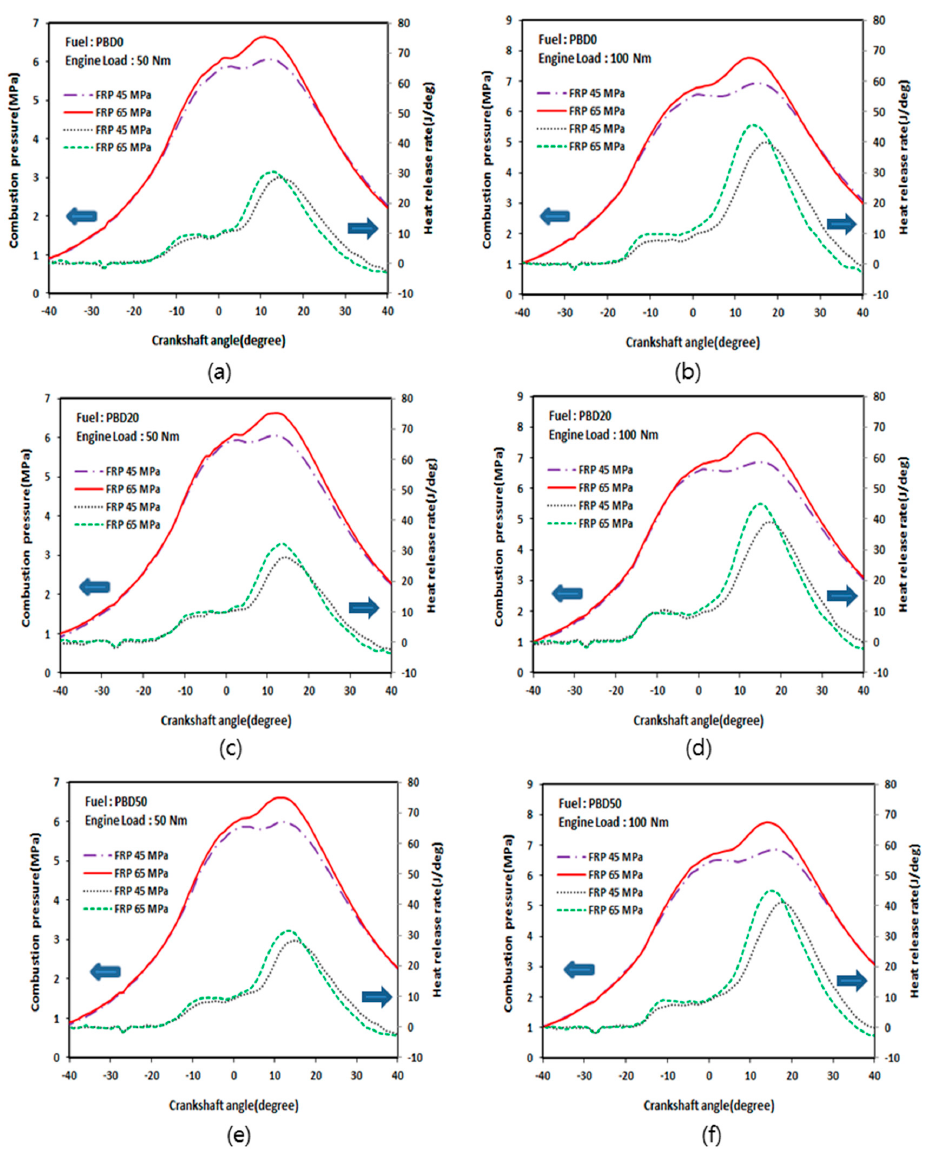
Figure 3. Combustion pressure and heat release rate in the combustion chamber for ( a ) PBD0 for an engine load of 50 Nm, ( b ) PBD0 for an engine load of 100 Nm, ( c ) PBD20 for an engine load of 50Nm, ( d ) PBD20 for an engine load of 100 Nm, ( e ) PBD50 for an engine load of 50 Nm and ( f ) PBD50 for an engine load of 100 Nm.